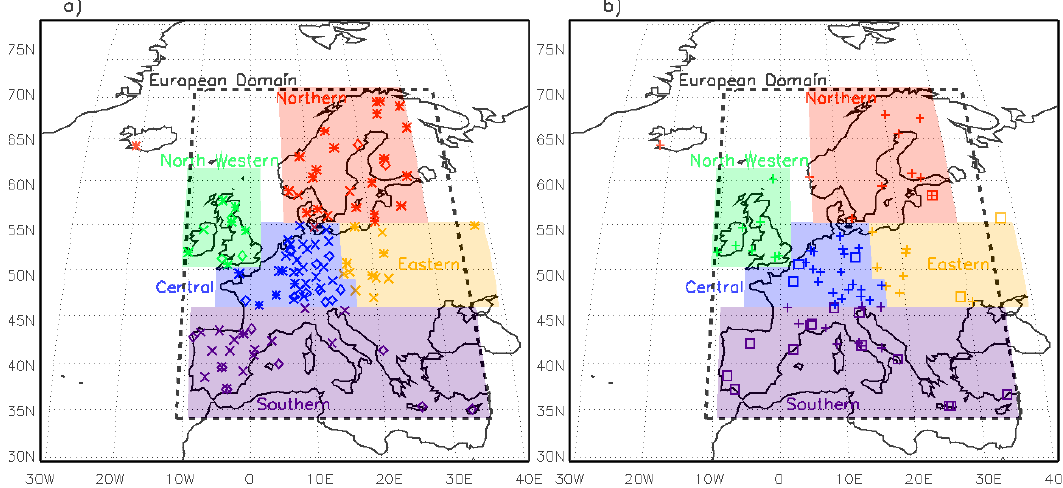
Figure 1. Location of measurements used in this study for (a) sulfate aerosol mass ( ∗ ), total aerosol mass ( ♦ ) and sites that have measured both ( × ), (b) AOD ( (cid:3) ) and surface solar radiation ( + ). Regional European definitions are north-western Europe (green), northern Europe (red), central Europe (blue), eastern Europe (orange) and southern Europe (purple).